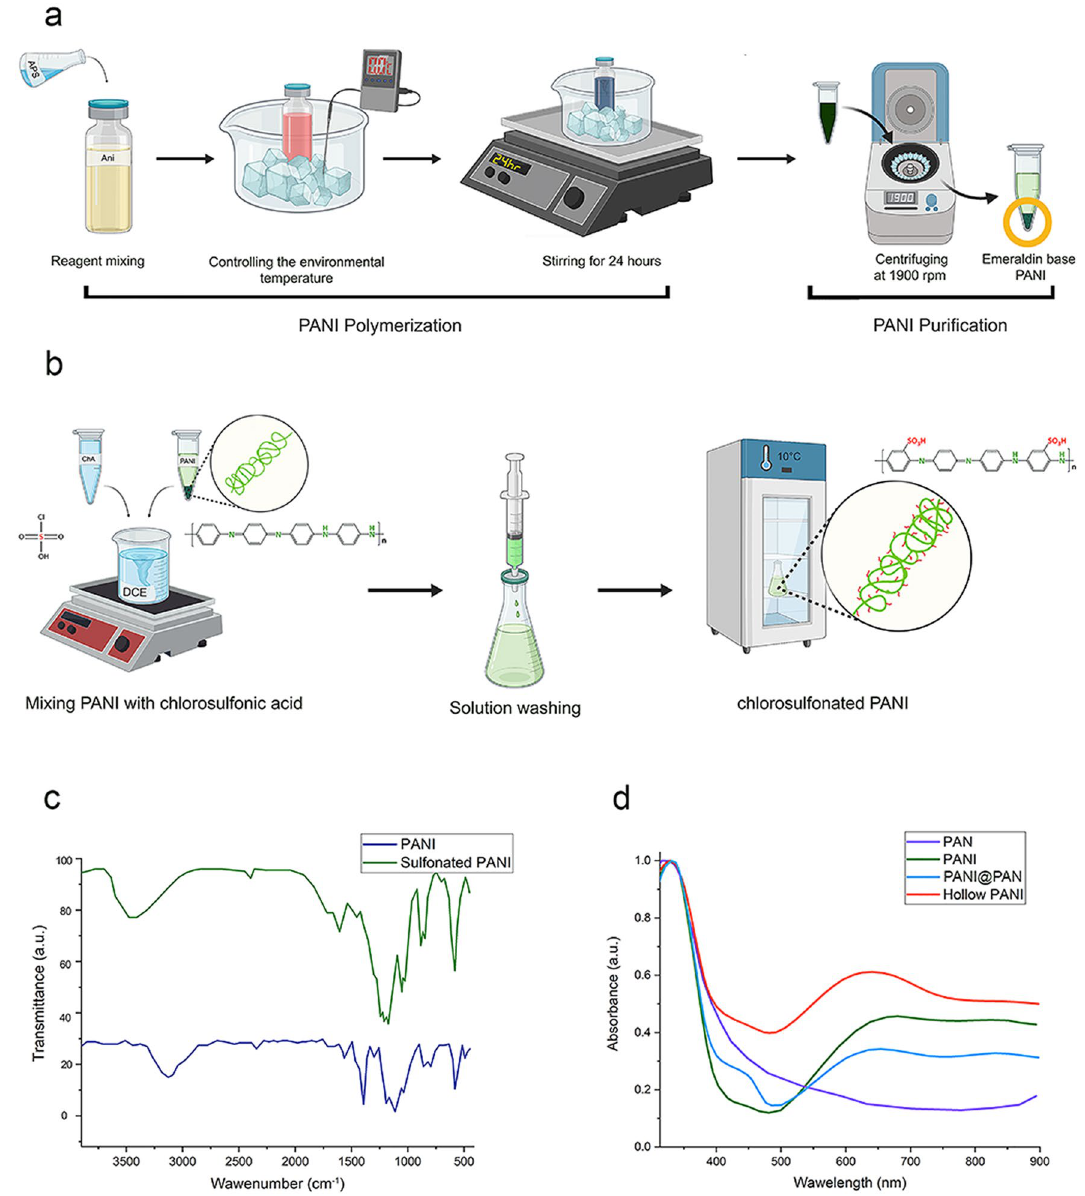
Figure 2. Step-by-step development of hollow core nanostructured fibers. ( a ) Sketch showing the synthesis of emeraldine base PANI starting from monomers. ( b ) Chemical reaction scheme to obtain sulfonated PANI. ( c ) FT-IR spectra of PANI and sulfonated PANI showing the absorption of the sulfonic group at around 3450 cm −1 . ( d ) UV–Vis absorption spectra of the four polymer structures: PAN, PANI, PANI@PAN, and hollow core PANI